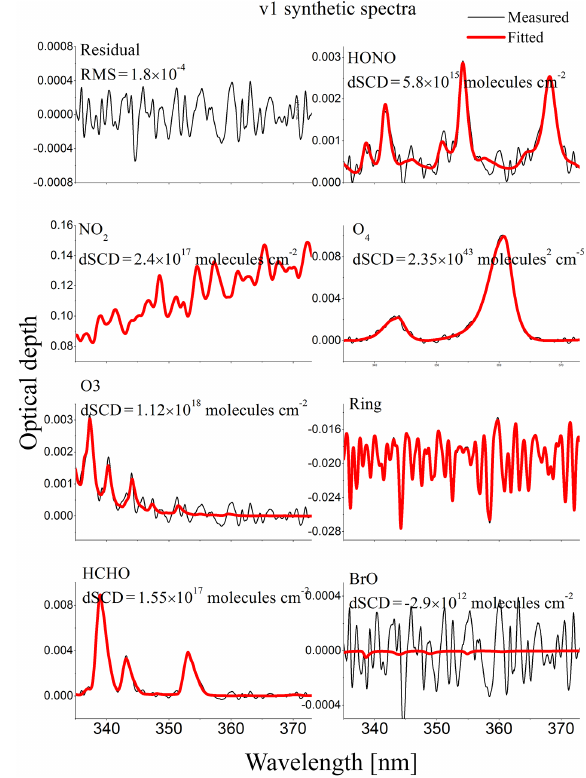
Figure 7. Example of a HONO fit of a V1 synthetic spectrum for a SAA of 166 ◦ and EA of 1 ◦ using the DOAS setting with a se- quential FRS without the intensity offset correction (setting #4 in Table